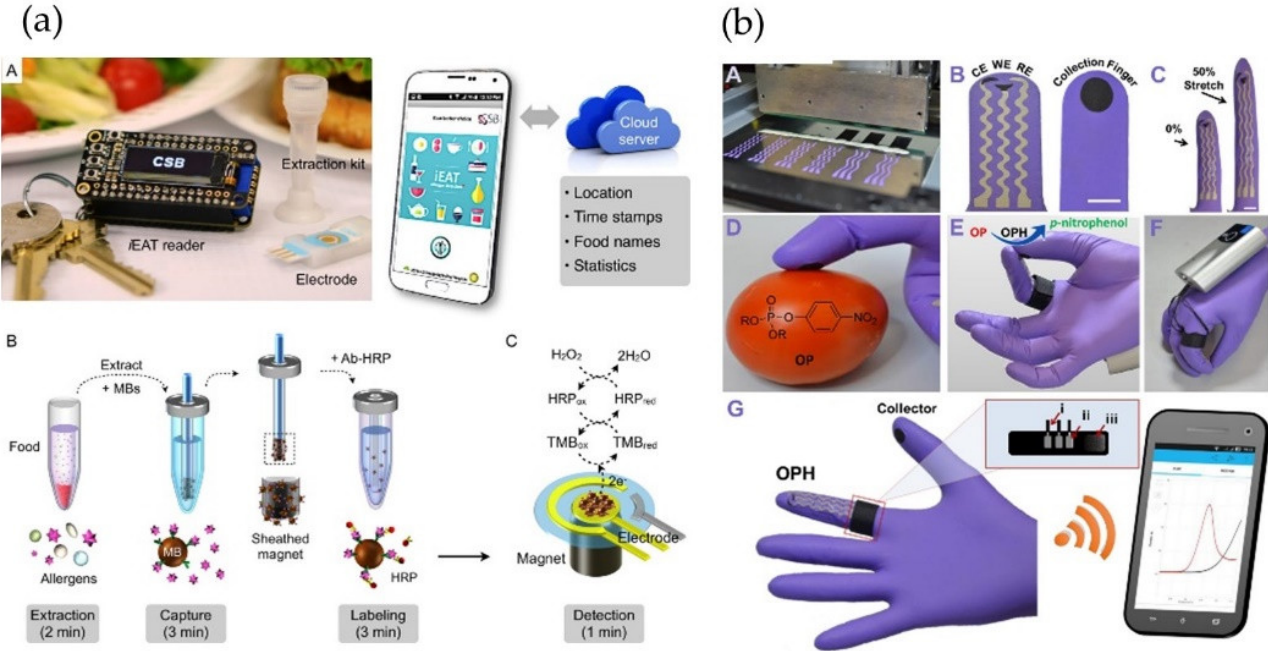
Figure 7. Examples of smartphone-based electrochemical food analyzers. ( a ) The iEAT platform. The keychain-sized detector is linked with a smartphone App. After extraction of the antigen from the sample, the detection is achieved by mixing HRP-labelled magnetic beads with the substrate (TMB, 3,3 (cid:48) ,5,5 (cid:48) - tetramethylbenzidine) and moving it to the electrode. Reproduced with permission from [132] ACS Nano, Copyright (2017), American Chemical Society; ( b ) The lab-on-a-glove platform. The glove biosensor consists of a sampling finger and a sensing finger, containing the immobilized enzyme. Reproduced with permission from [133] ACS Sensors, Copyright (2019), American Chemical